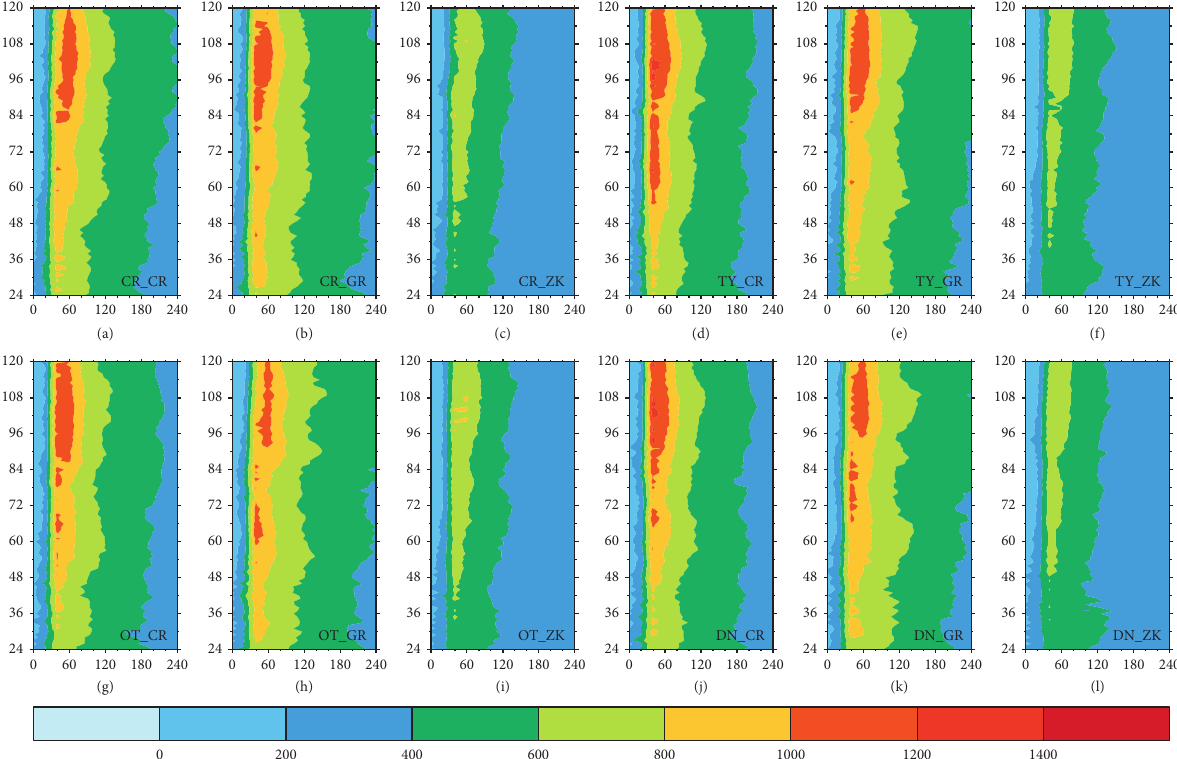
Figure 7: Hovm¨oller diagrams of azimuthally averaged latent heat flux (W/m 2 ) from 12 experiments. x -axis denotes the distance (km) from the center of the typhoon and y -axis denotes the forecast